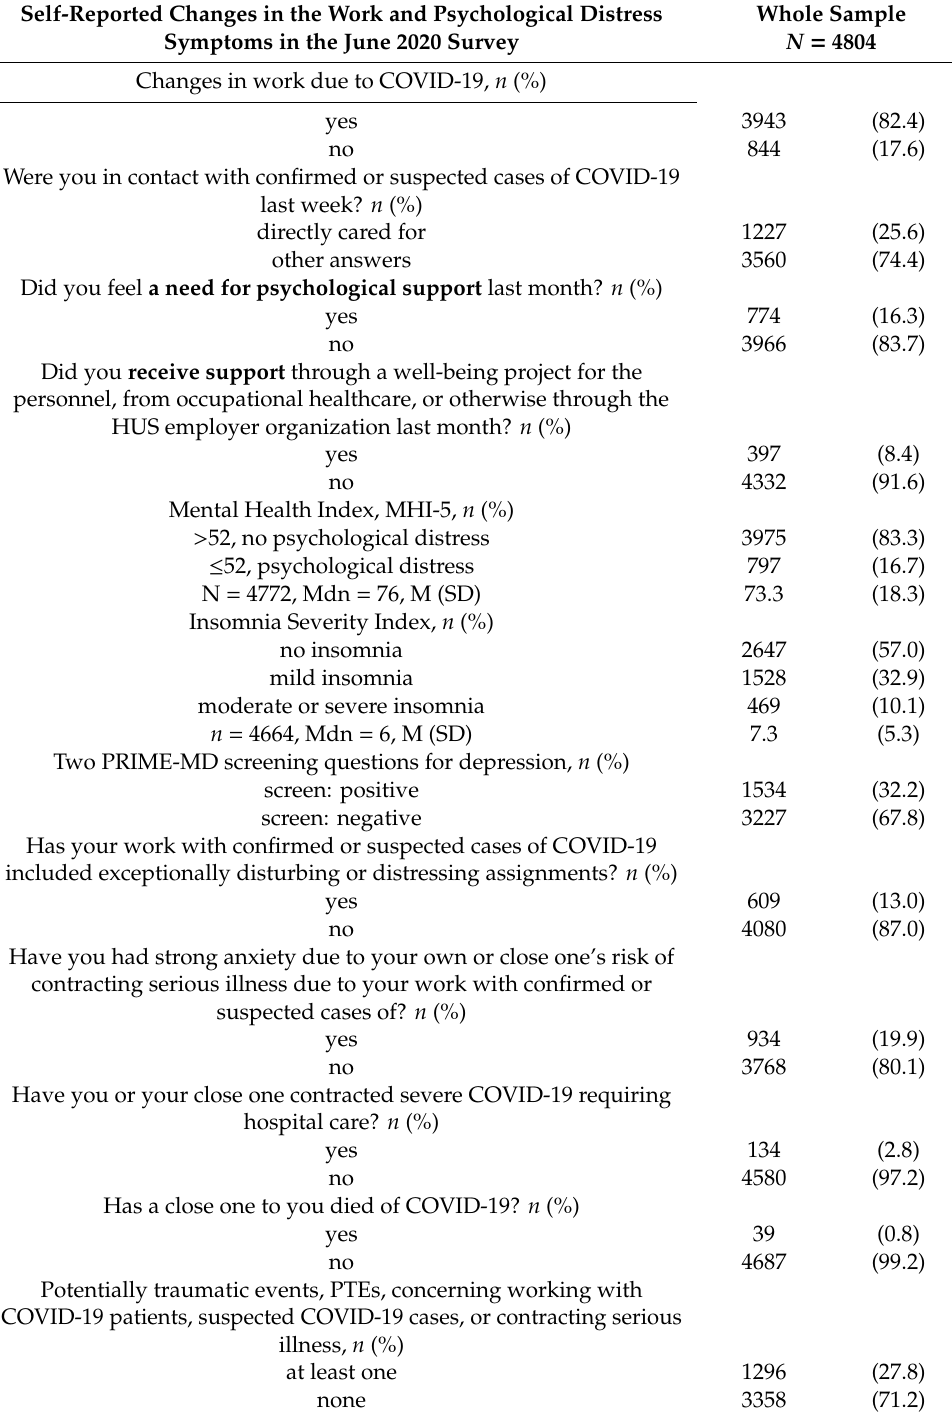
Table 2. Potentially traumatic events related to work with COVID-19 patients, work changes, and psychological symptoms among the HUS personnel participants of the well-being survey. Self-Reported Changes in the Work and Psychological